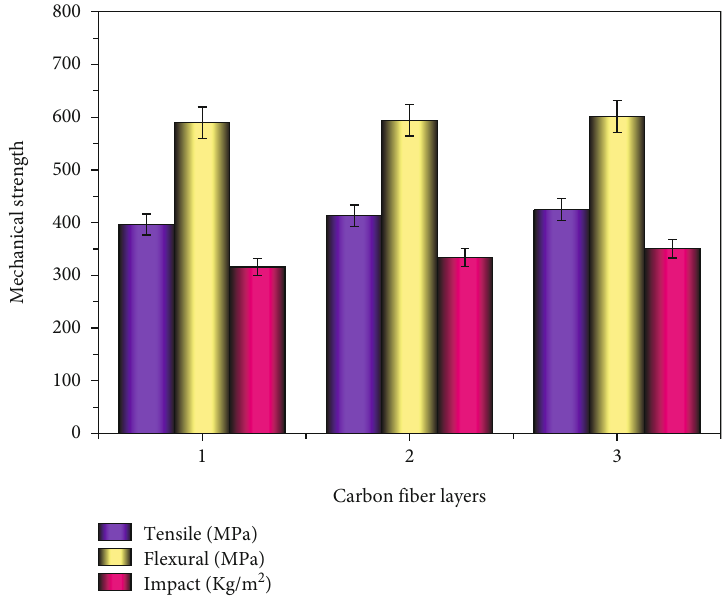
Figure 6: Mechanical properties of nanocomposites based on number of layers of carbon fi ber.